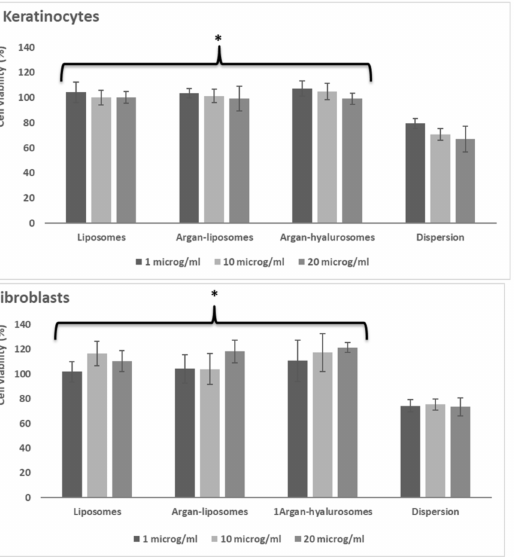
Figure 6. Viability of keratinocytes and fibroblasts incubated for 48 h with neem oil in dispersion or loaded in liposomes, argan-liposomes and argan-hyalurosomes at 3 different dilutions (1, 10 and 20 µ g/mL of neem oil). Symbol (*) indicates the same value significantly different from the neem oil dispersion ( p <